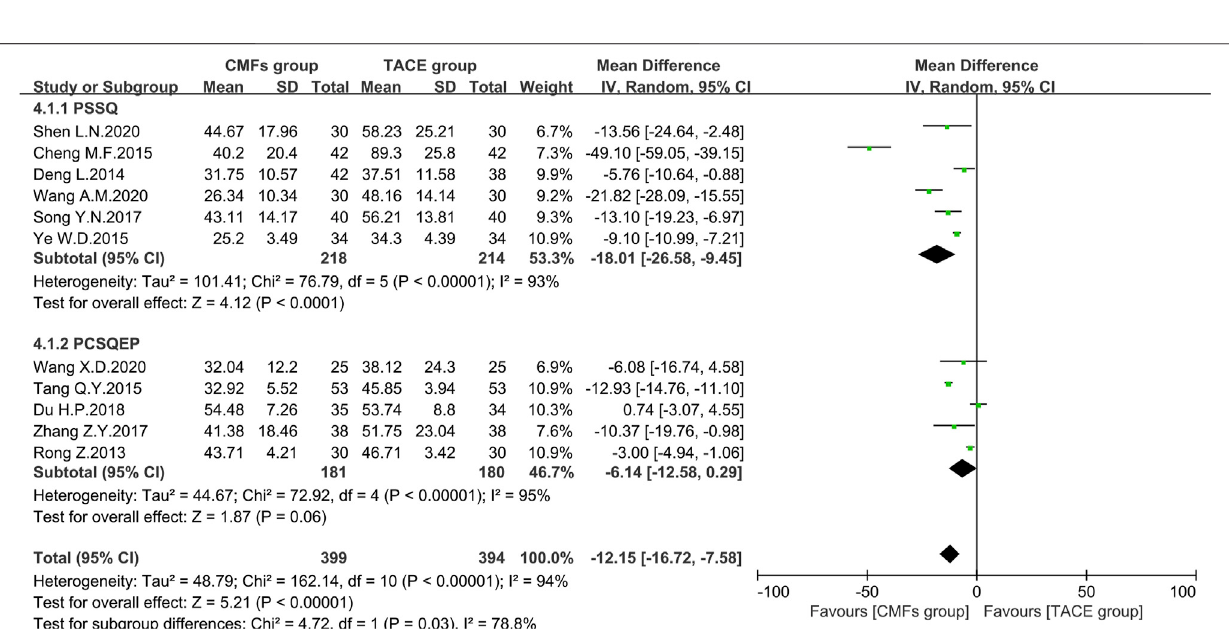
Frontiers in Pharmacology |